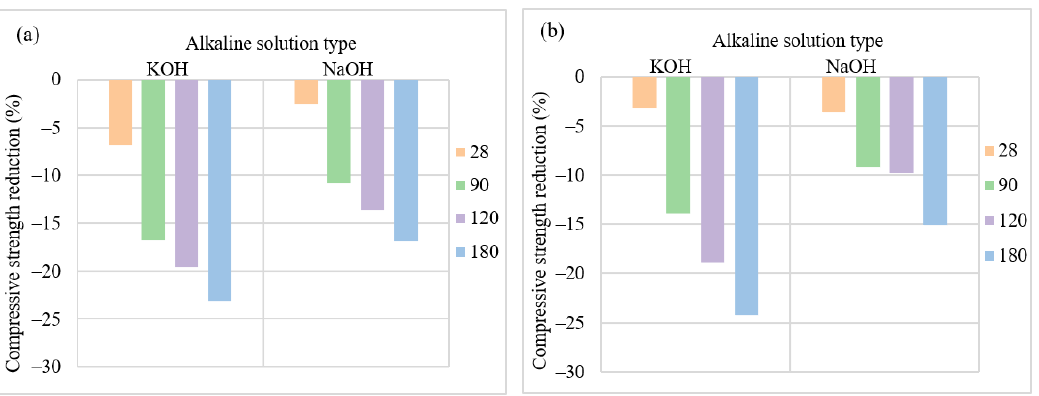
Figure 3. The effects of KOH replacement on compressive strength reduction at a molarity of 6, A/S = 0.4 and ( a ) NO/NS = 1, and ( b ) NO/NS = 3. A/S = 0.4 and ( a ) NO/NS = 1, and ( b ) NO/NS =